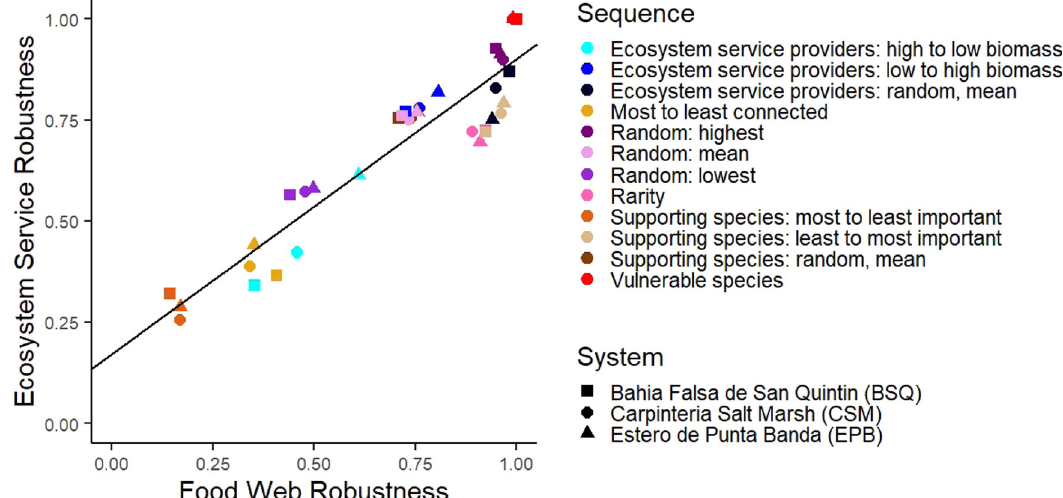
Fig. 3 Food web and ecosystem service robustness are highly and positively correlated ( r s [36] = 0.884, P = 9.504e – 13). We ran a two-tailed Spearman ’ s correlation test on the food web and ecosystem service robustness for all 3 systems and all 12 sequences. The black line is a regression line. The shape of data points represents the salt marsh system: Bahia Falsa de Sant Quintin (square, Fig. 1c), Carpinteria Salt Marsh (circle, Fig. 1a), and Estero de Punta Banda (triangle, Fig. 1b). The color denotes the sequence of species removals: ecosystem service providers (removed by biomass and randomly), supporting species (removed by high-to-low importance, low-to-high importance, and randomly), most-to-least connected, randomly (reporting: highest, lowest and mean, n = 1000 randomizations), rarity (removed by relative abundance — from least to most abundant), and vulnerable species (removed from least to most abundant).